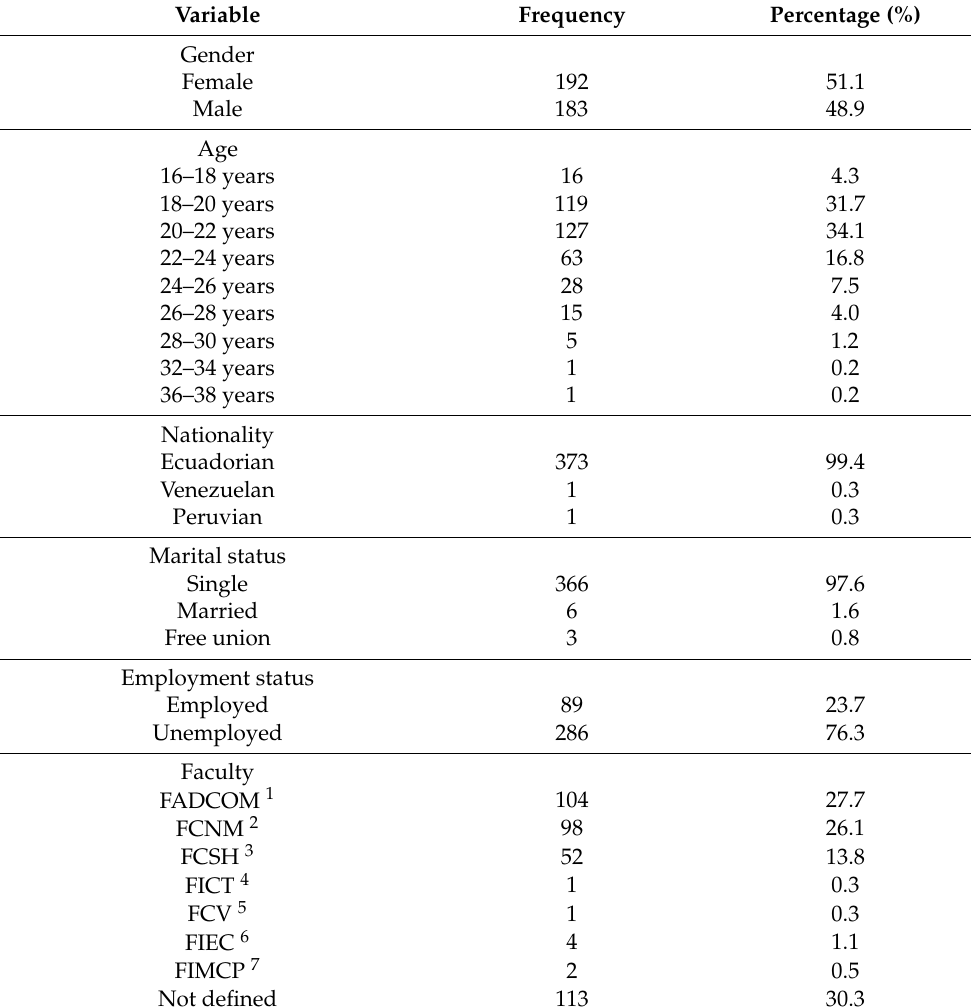
Table 2. Demographic characteristics of